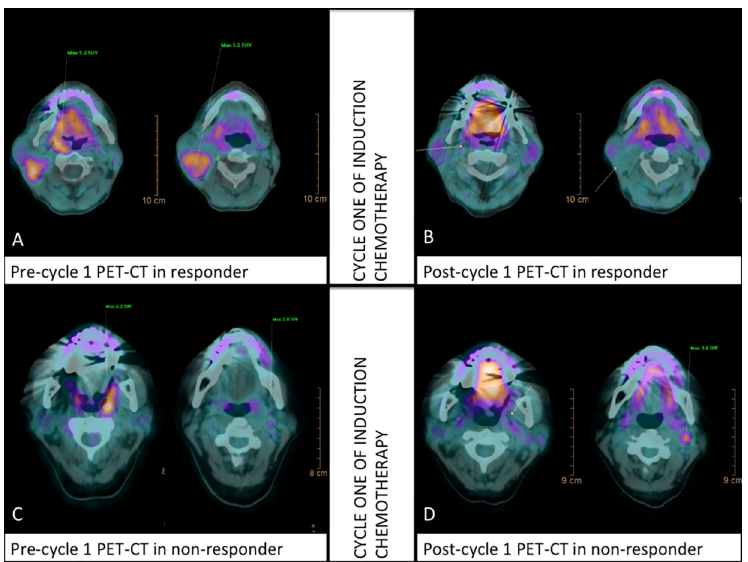
Fig 2. Two patients presenting metabolic responsive and non-responsive tumors/ neck lymph node after once IC cycle. Pretreatment PET/CT(A) and post-treatment PET/CT(B) in patient harboring oropharyngeal tumor with complete metabolic response at 14 th day, cycle 1 of induction chemotherapy (SUV variation from 5.1 to 0.0 and 5.3 to 0.0 in lymph node and primary tumor respectively). Pretreatment PET/CT(C) and post-treatment PET/CT(D) in patient harboring non-responsive oropharyngeal tumor with Increased metabolic response at 14 th day, cycle 1 of induction chemotherapy (neck lymph node SUV variation from 2.8 to 3.6, despite achieving a complete metabolic response in primary tumor).